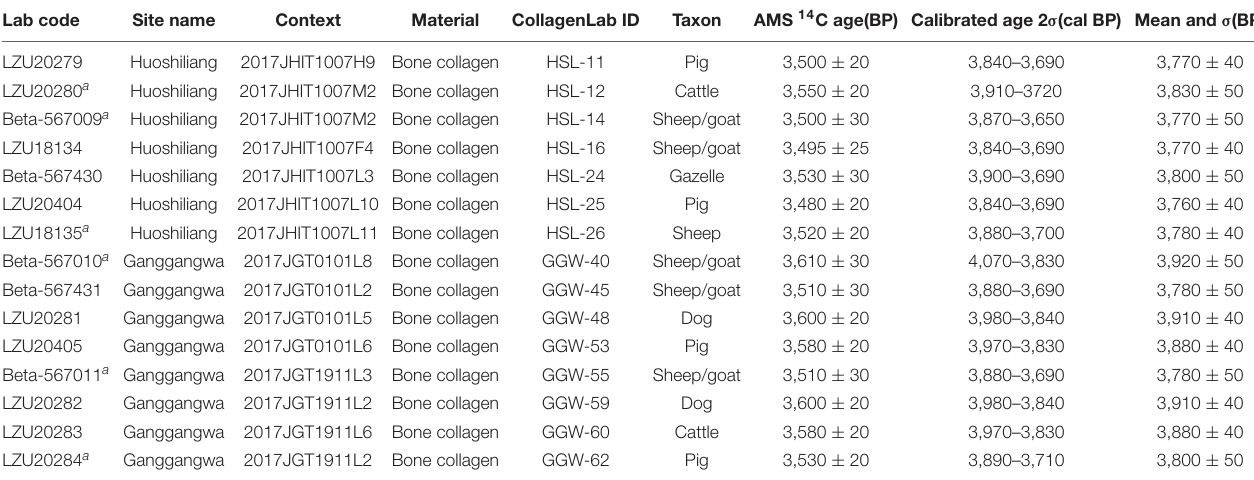
TABLE 3 | Radiocarbon dating results of animal bones excavated from Huoshiliang and Ganggangwa